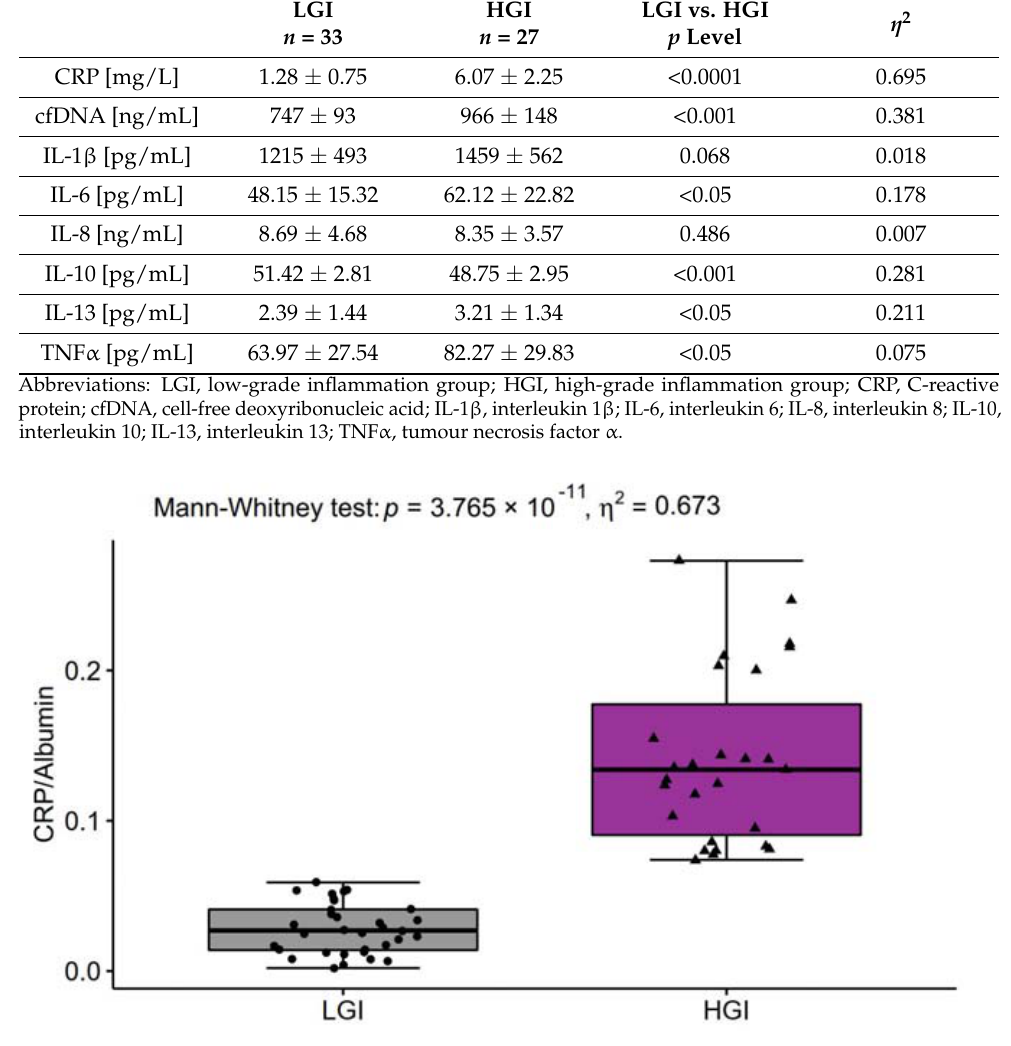
Figure 3. The ratio of C-reactive protein (CRP) to albumin in low-grade inflammation group (LGI, n = 33) and in high-grade inflammation group (HGI, n = 27). Table 7. The relationships of cell-free DNA with other age-associated inflammation markers ( n = 60). Statistically significant values are marked in